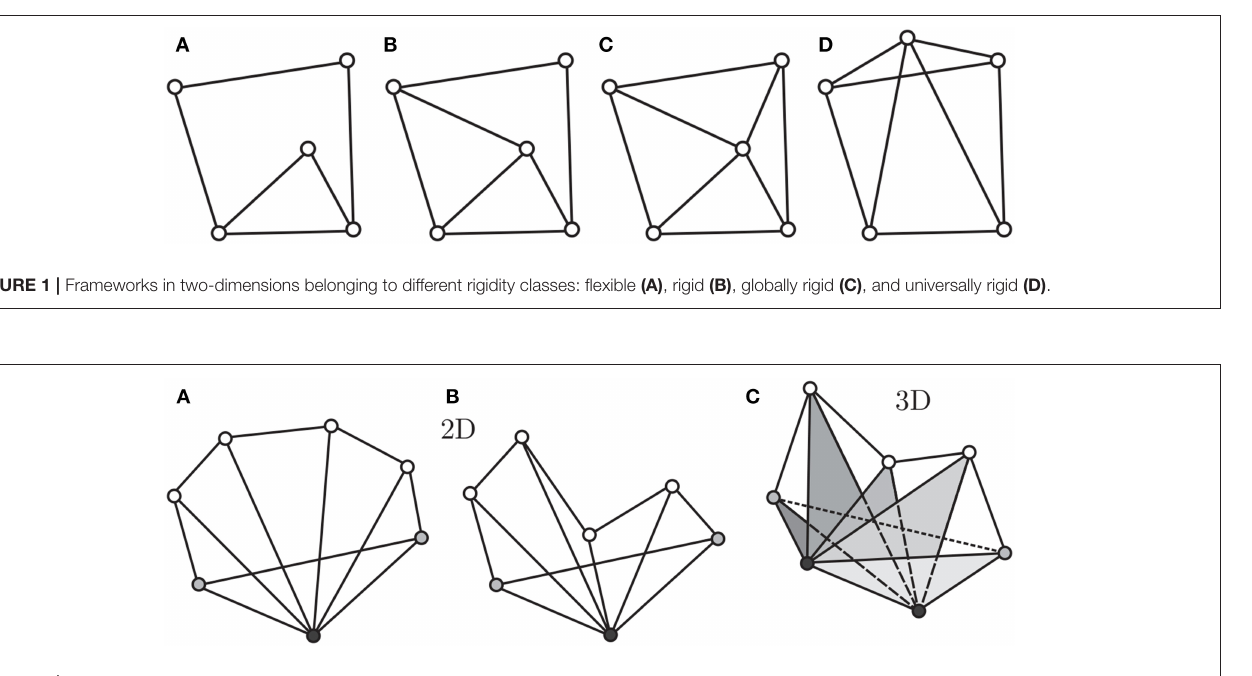
FIGURE 2 | A Grünbaum polygon (A) , and its nonconvex generalizations in two (B) and three dimensions (C) . Center nodes and neighboring nodes (as defined in Section 3.1) are depicted in black and gray,